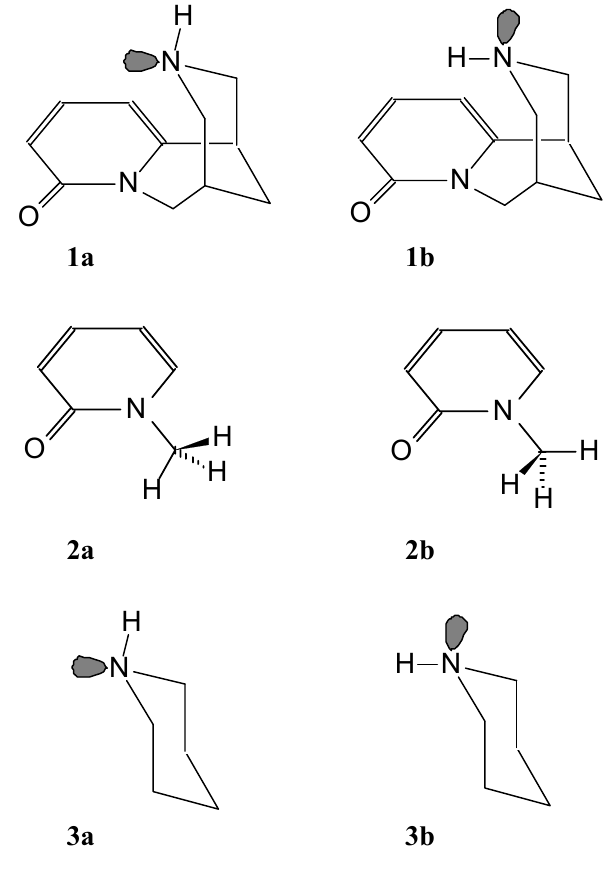
Figure 1 . The most stable conformations for neutral cytisine ( 1a and 1b ) and its model compounds: N -methyl-2-pyridone ( 2a and 2b ) and piperidine ( 3a and 3b